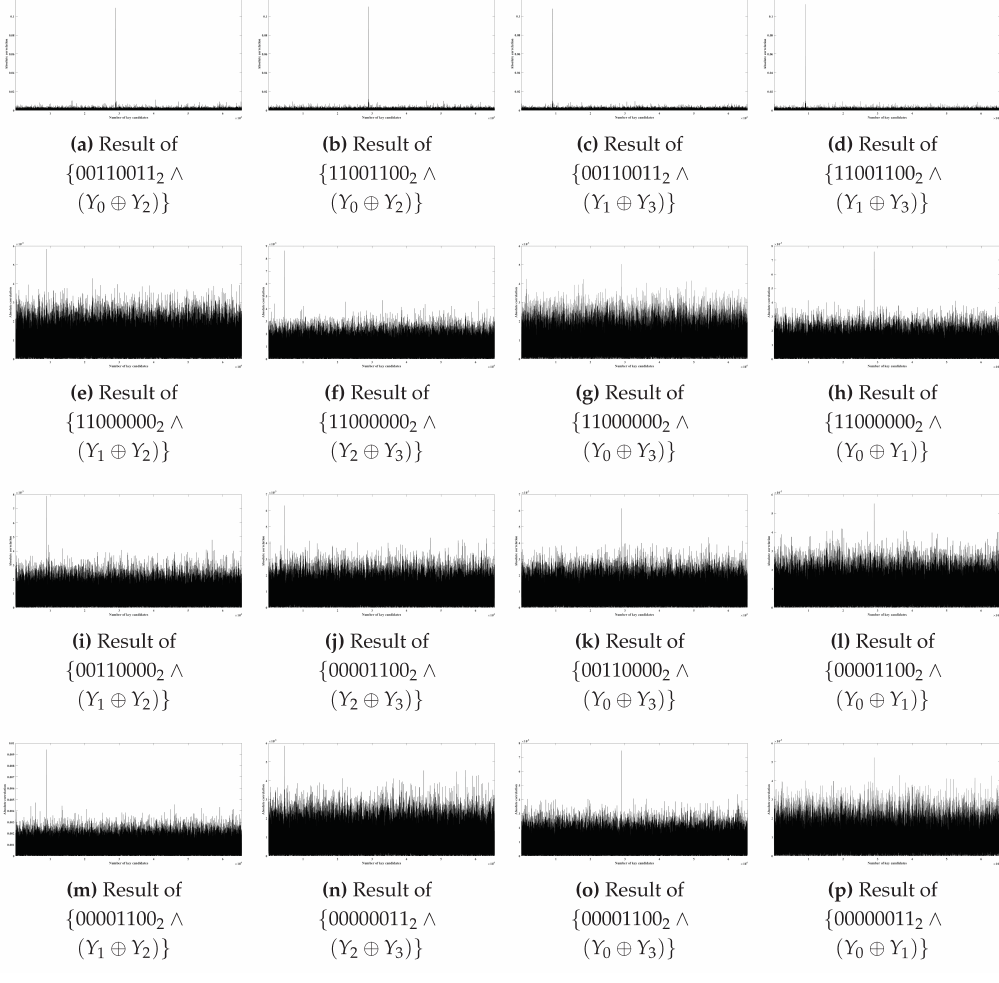
Figure 8. When performing combinations defined in item 2b, the result is only represented if the correct key is revealed. Table 1. Analyzed two round keys. Round